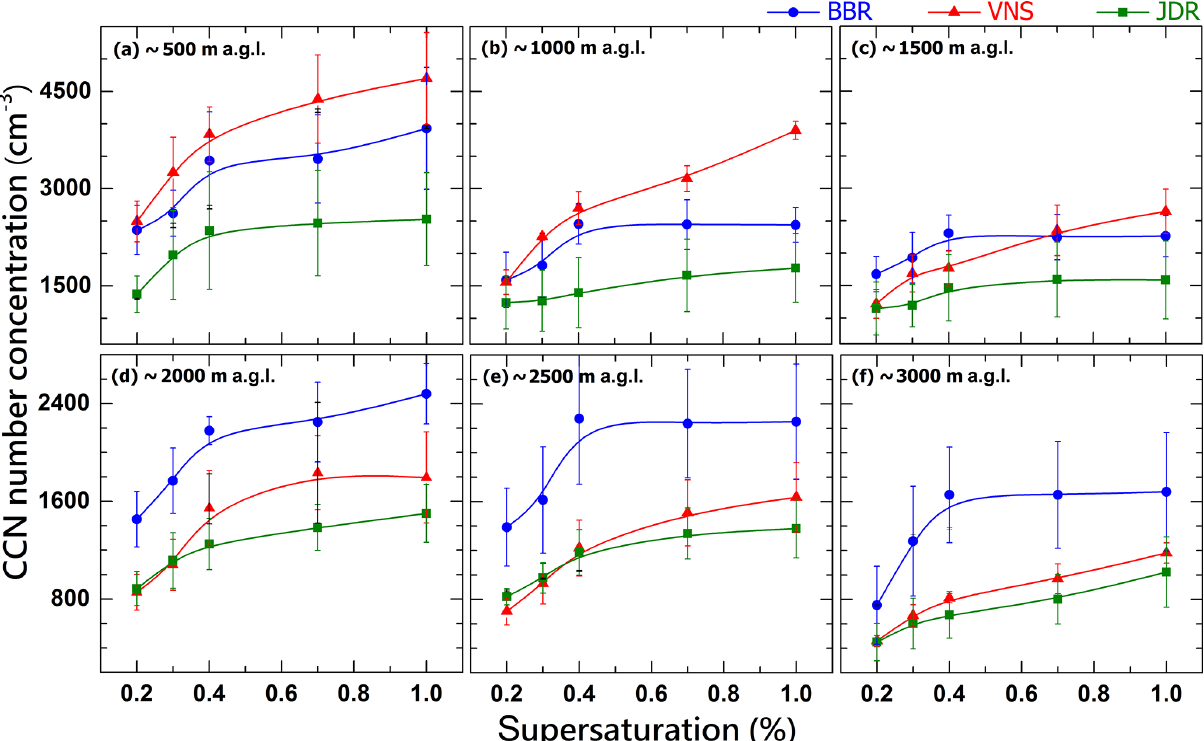
Figure 6. Mean CCN spectra at six altitudes levels over different subregions of the IGP. The error bars indicate the standard deviation around the mean. The points correspond to measurements, while the lines are the empirical fits. The circle, triangle and square represent the eastern (BBR), central (VNS) and western (JDR) IGP subregions,